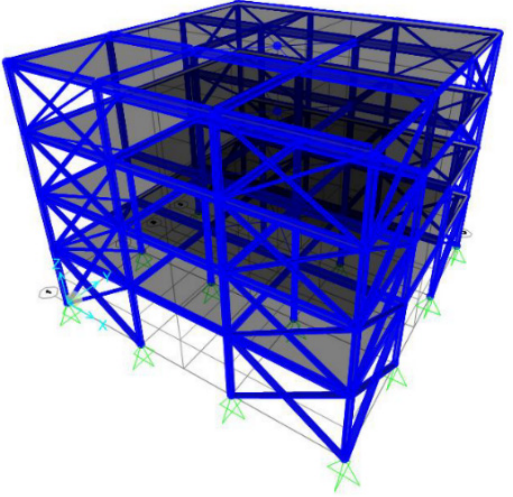
Figure 18. Multi-storey building model with SAP2000 for case studies 5 and 6. Table 14. Results of case study 5 (L: level; S: step). Table 11. Ratios between the shears from the linear dynamic analysis with corrected stiffness, and linear static analysis for one-floor building case studies.